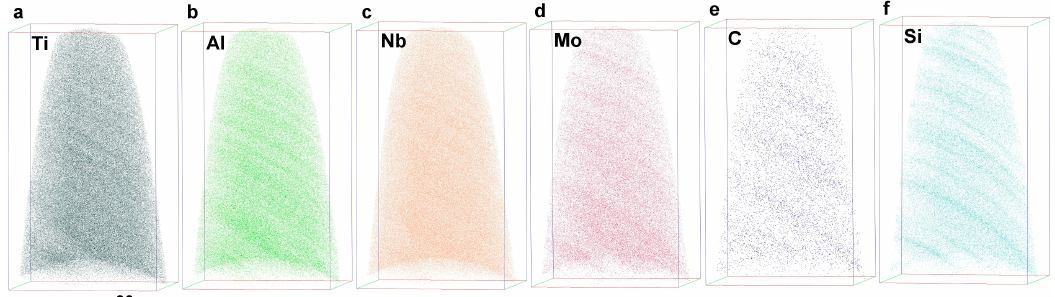
Figure 10. Reconstructions of the lamellar structure of a TNM + alloy. In all images, the lamellar structure is visible to different extents corresponding to different partitioning ratios. Carbon shows a tendency to accumulate in the α 2 phase and Si partitions even more pronounced to this phase. See Table 2 for quantitative analysis.